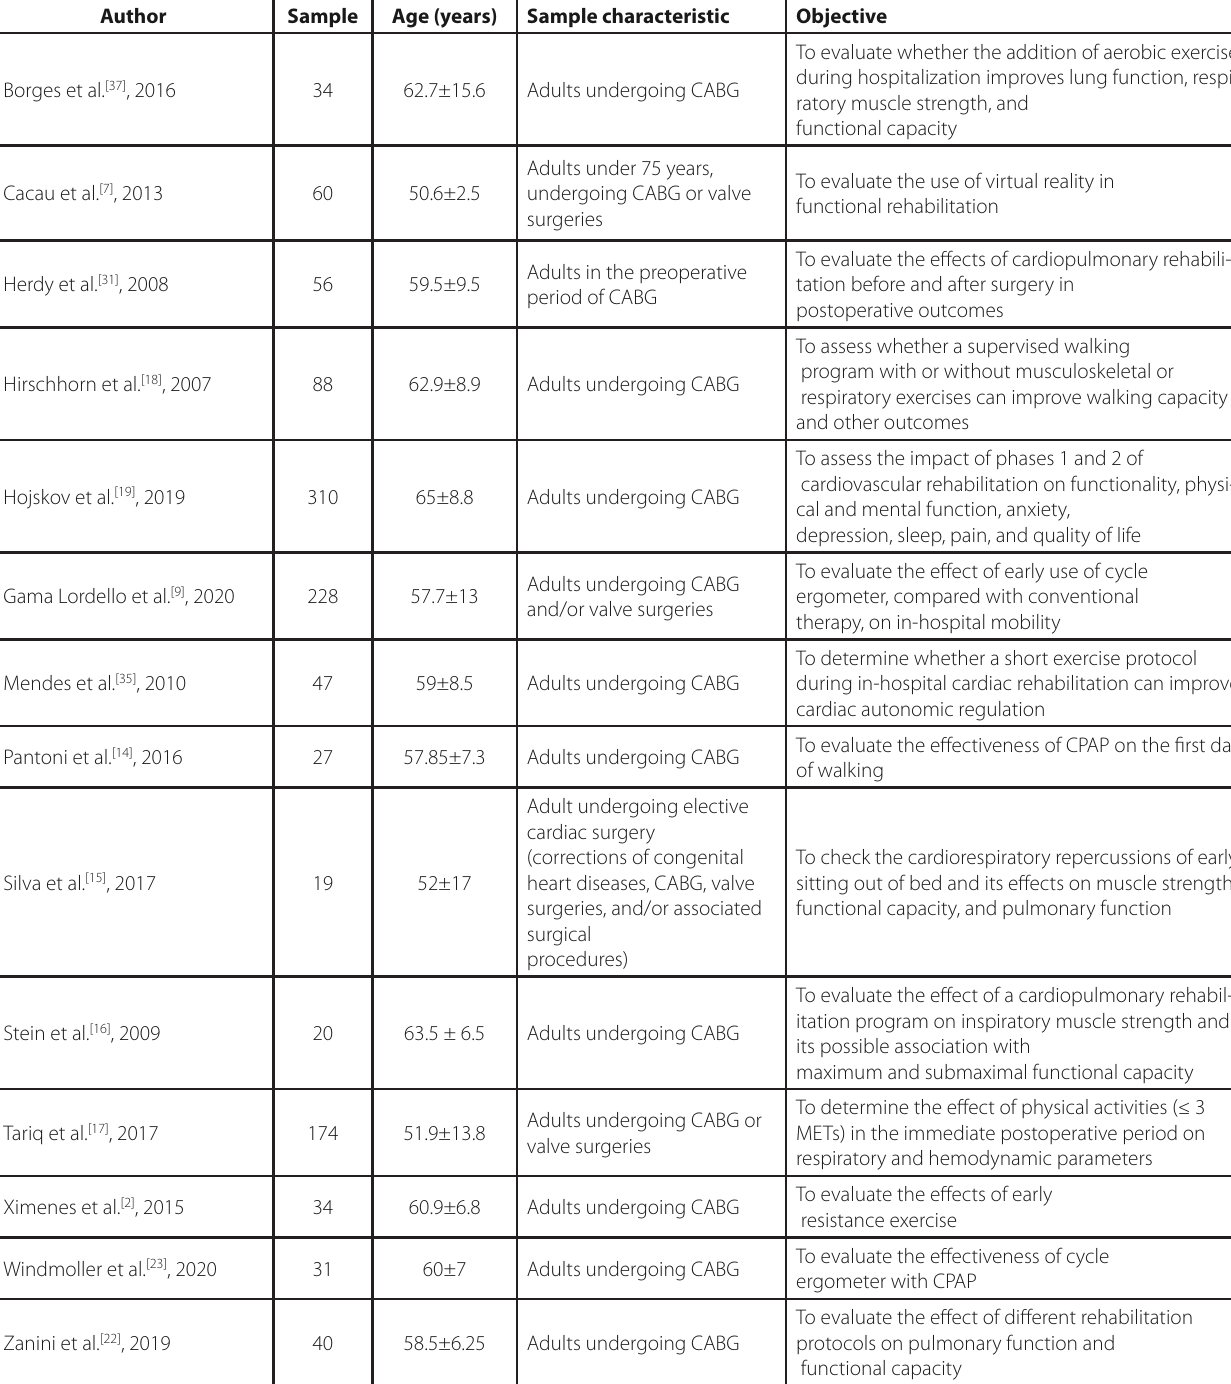
Table 2. Characteristics of the included